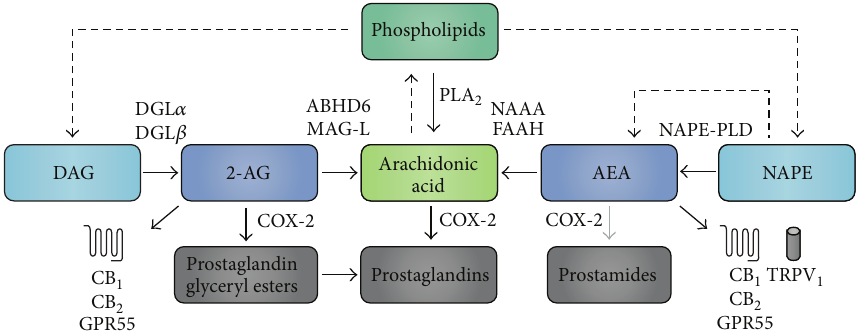
Figure 1: Overview of AEA and 2-AG production and metabolism. The endocannabinoids 2-AG and AEA are formed from arachidonic acid-containing phospholipids. 2-AG is formed from DAG by DGL 𝛼 or DGL 𝛽 and is metabolized either via COX-2 to form prostaglandin glyceryl esters or by ABHD6 or MAG-L to form arachidonic acid. The production of AEA occurs through conversion of NAPE by either a NAPE-PLD dependent or independent pathway. Once formed, AEA is broken down by either NAAA or FAAH to form arachidonic acid or occasionally by COX-2 to form prostamides. Arachidonic acid can be synthesized via phospholipase A 2 (PLA 2 ) from phospholipids and is also broken down by COX-2, forming prostaglandins and other eicosanoids. Additionally, arachidonic acid can be converted back to a phospholipid [30, 31]. Dashed lines indicate multistep pathway; gray lines indicate weak